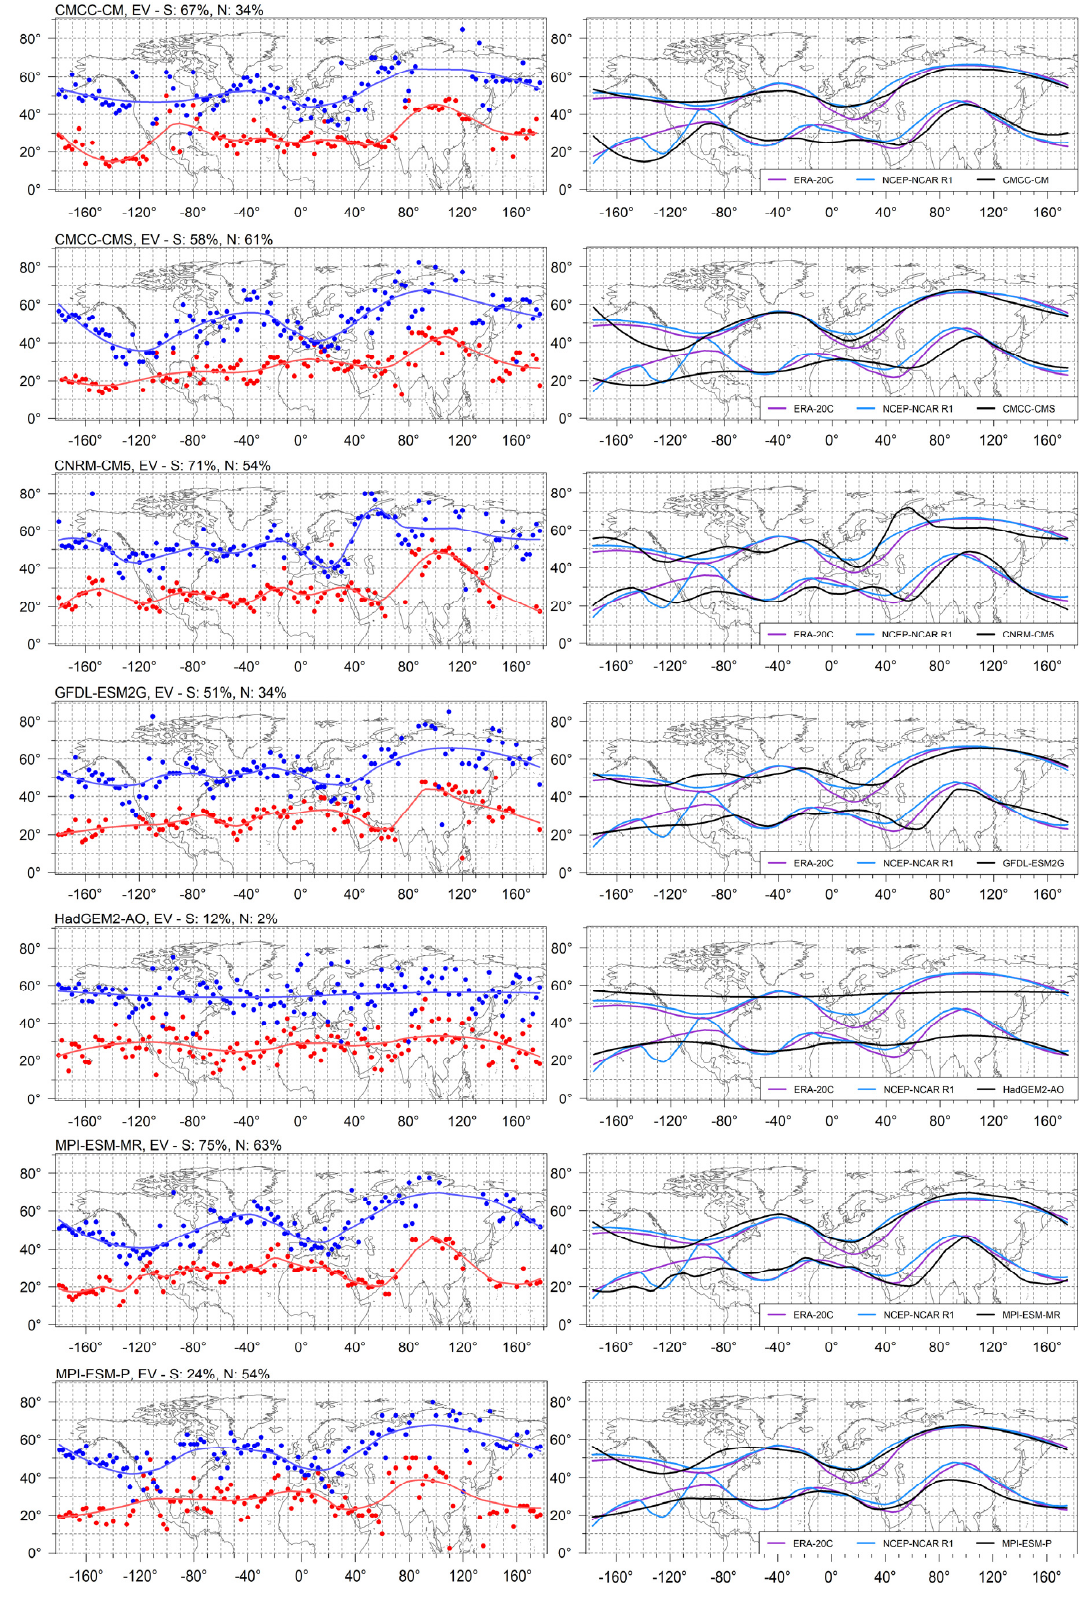
Figure 7. Loess regression curves fitted on the PotACs of selected GCMs (first column), and comparison of the curves with the loess regression curves obtained from the reanalyses (second column). In the case of the first column see Figure 6 for the explanation of the symbols and colors.